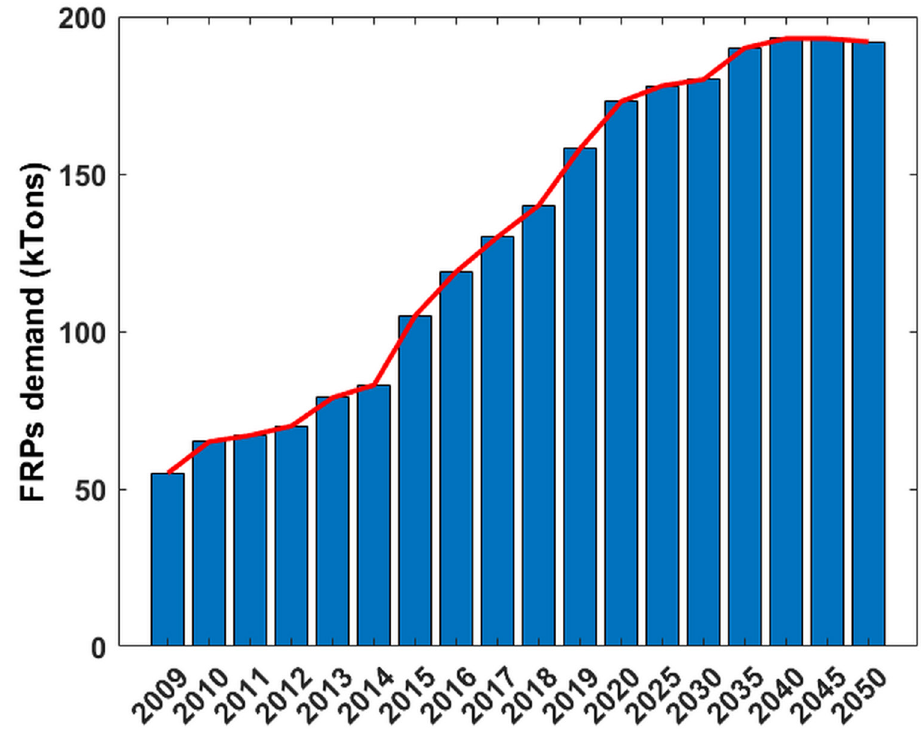
Figure 1. CFRP demand over the years